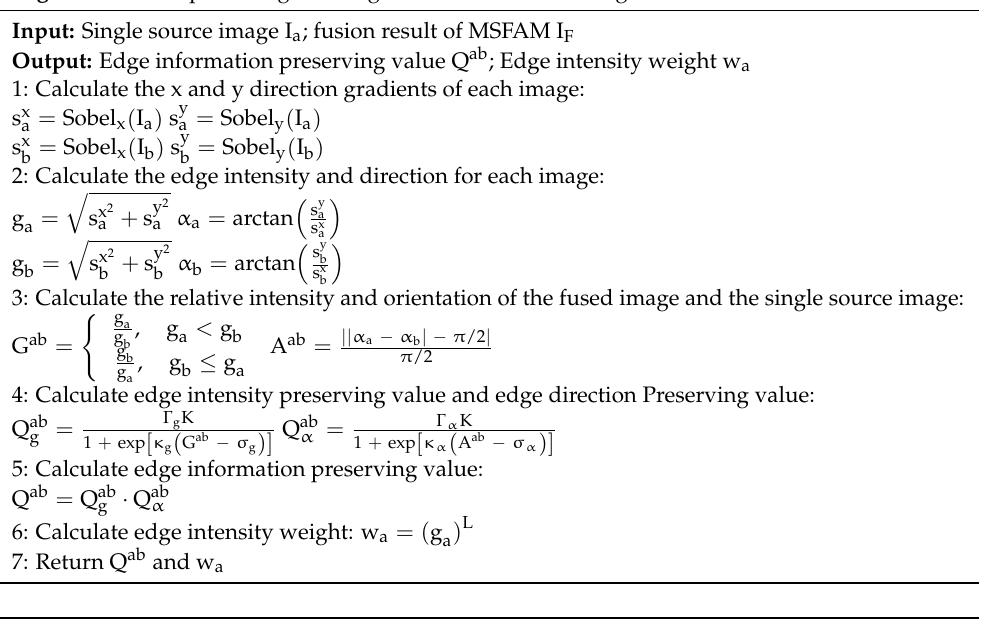
Algorithm 1 Compute Weighted Edge Information Preserving Value